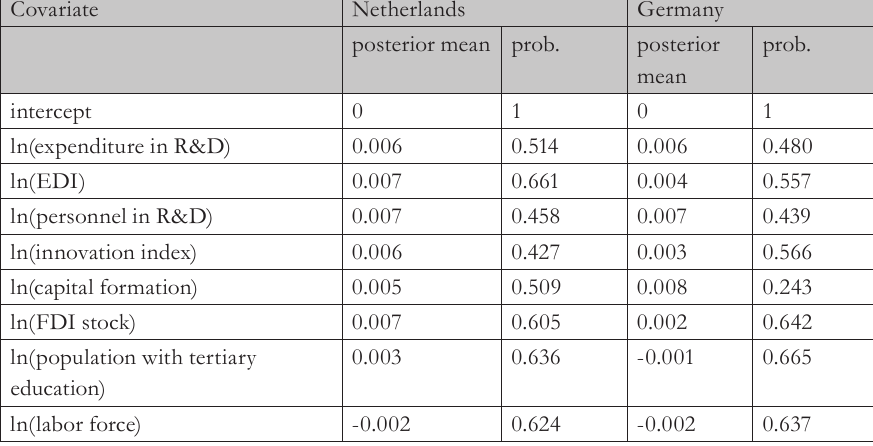
Tab. 6 − Ridge regressions with marginal MLE to explain GCI in the Netherlands and Germany (2004-2018). Source: own